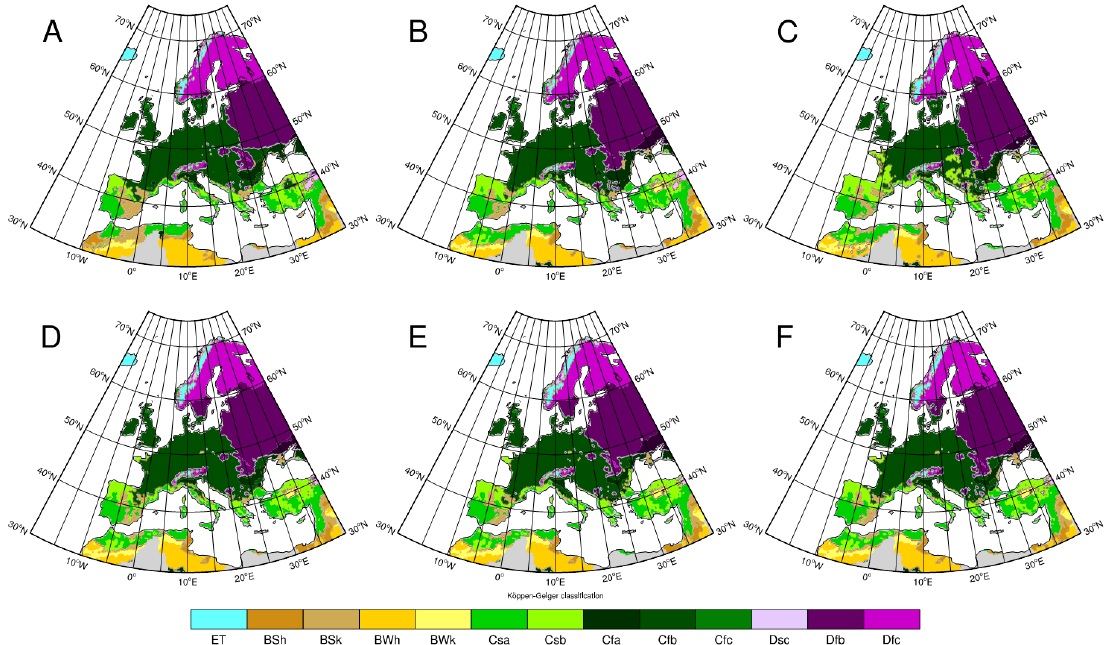
Figure 10. Simulated K-G climate classification according to E-OBS ( A ) and local intensity scaling of precipitation and variance scaling of temperature correction in ALADIN ( B ), HIRHAM ( C ),